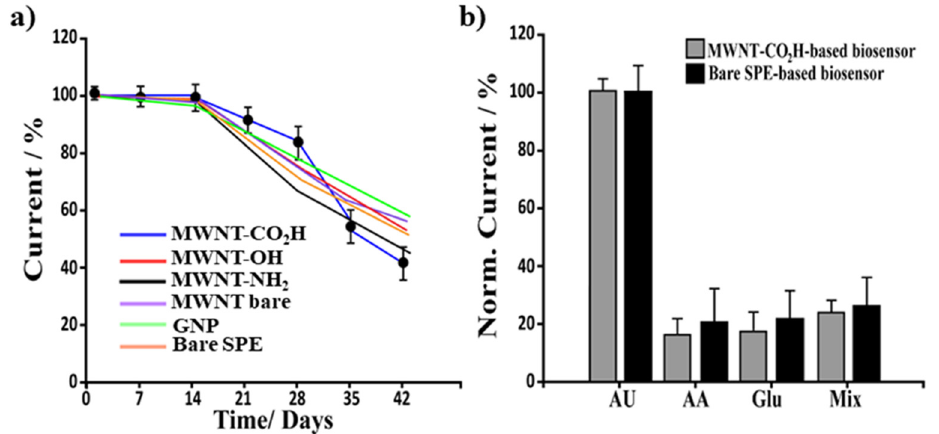
Figure 7. Stability and selectivity of CNMs-based UA biosensors. ( a ) Stability study. All the biosensors were tested after several days of storage at 4 °C in a humid chamber, and amperometrically analyzed at the indicated times with 10 μ M UA concentration. ( b ) Selectivity study. Effect of the presence of the AA, Glu, and their mix on the biosensor responses obtained for 10 μ M UA solution.